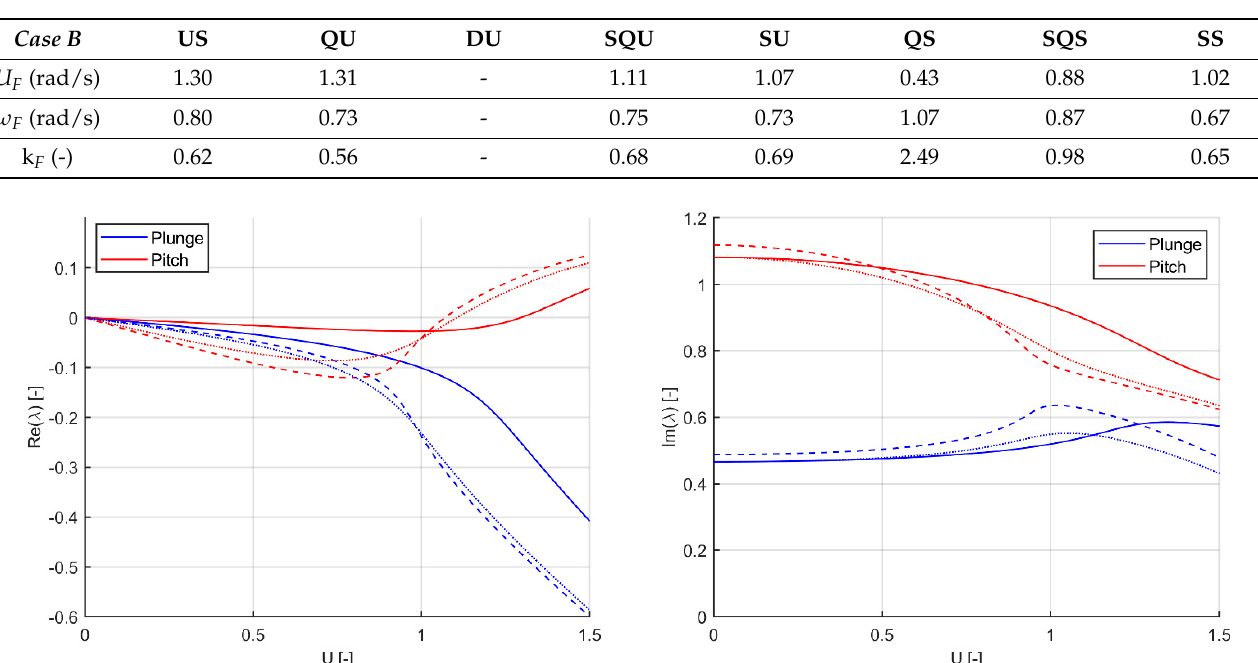
Figure 5. Evolution of the complex eigenvalues for Case B: real part ( left ), imaginary part ( right ); continuous, dashed and dotted lines for US, SU and SQU aerodynamic models, respectively.